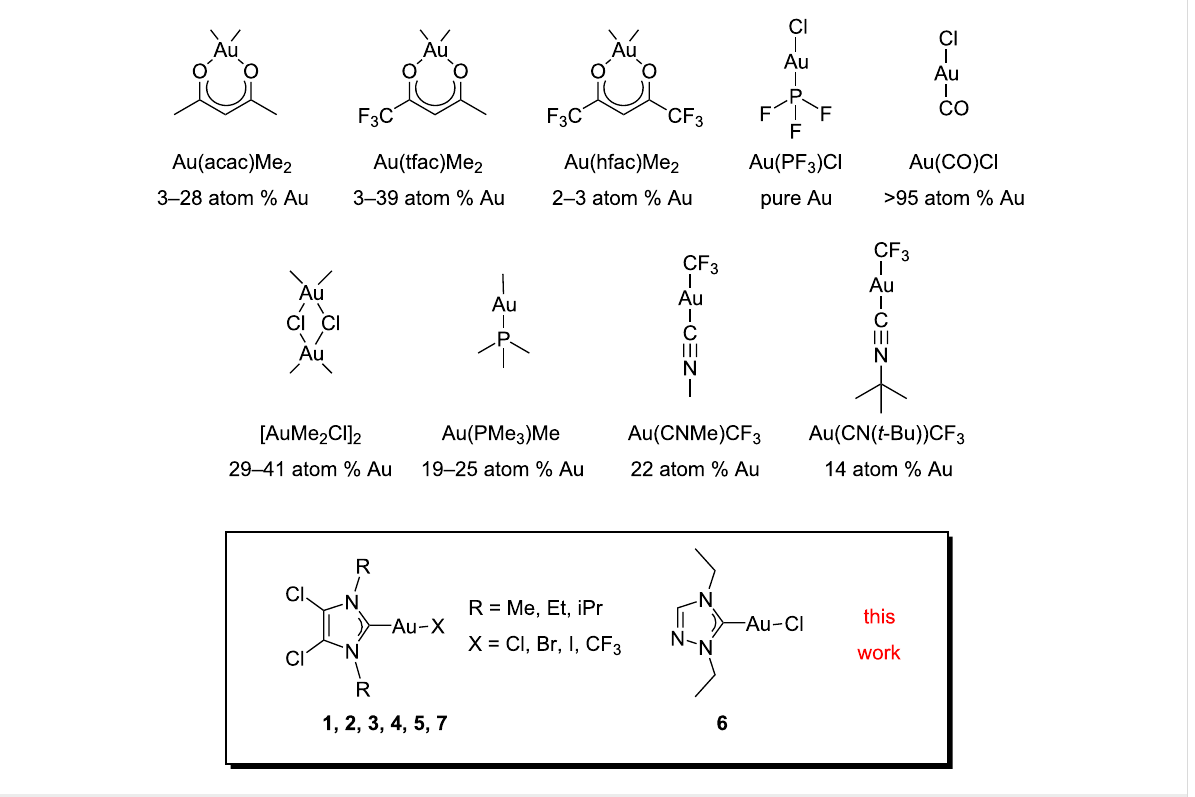
Figure 1: Overview of previously reported FEBID gold precursors, Au(acac)Me 2 [10,20-22], Au(tfac)Me 2 [21,23-25], Au(hfac)Me 2 [19], Au(PF 3 )Cl [27- 30], Au(CO)Cl [31], [AuMe 2 Cl] 2 [32], Au(PMe 3 )Me [32,33], Au(CNMe)CF 3 [34], and Au(CN( t -Bu))CF 3 [34], and the compounds studied in this work, labelled as 1 – 7